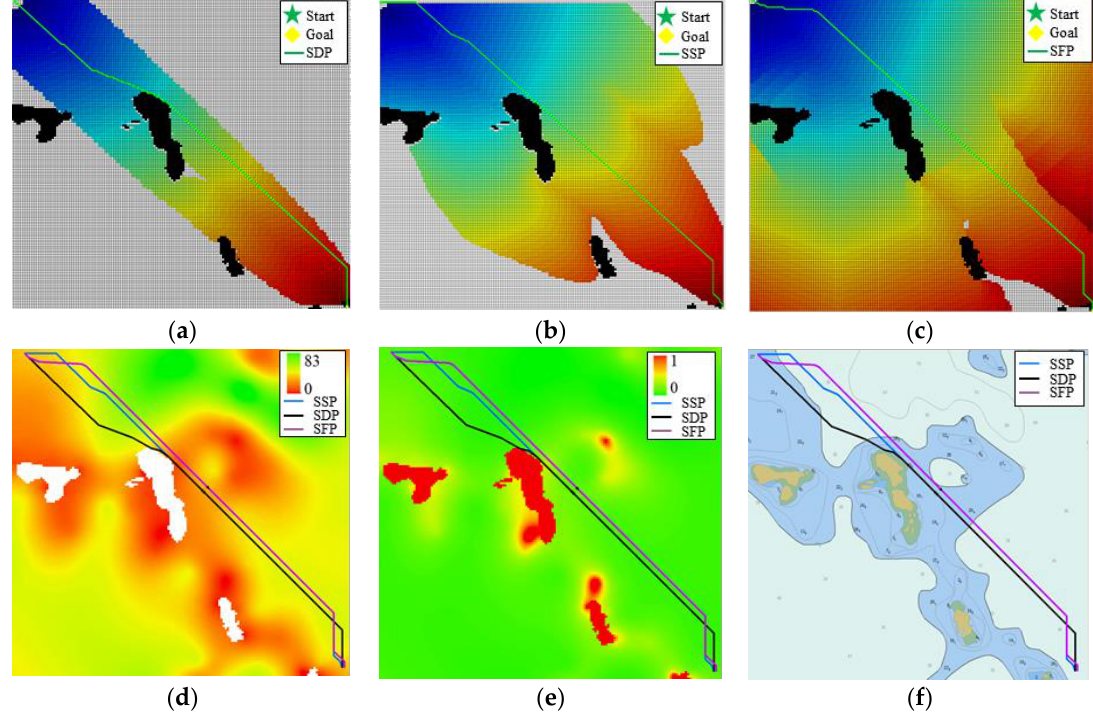
Figure 12. Comparison of three kinds path. ( a ) Shortest distance path (SDP) that ignores the depth risk; ( b ) Shorter and safer path (SSP) that considers the depth risk level and distance. ( c ) Safest path (SFP) that considers only the depth risk. The colorful grids in figure ( a – c ) are extended nodes. The space of white grids represents the feasible space, and the black grids are obstacles. ( d ) Three paths, shown on the depth distribution map. ( e ) Three paths, shown on the depth risk level distribution map. ( f ) Three paths, shown on S57 ENC. The black line is the SDP, the blue one is SSP, and the purple one is SFP.